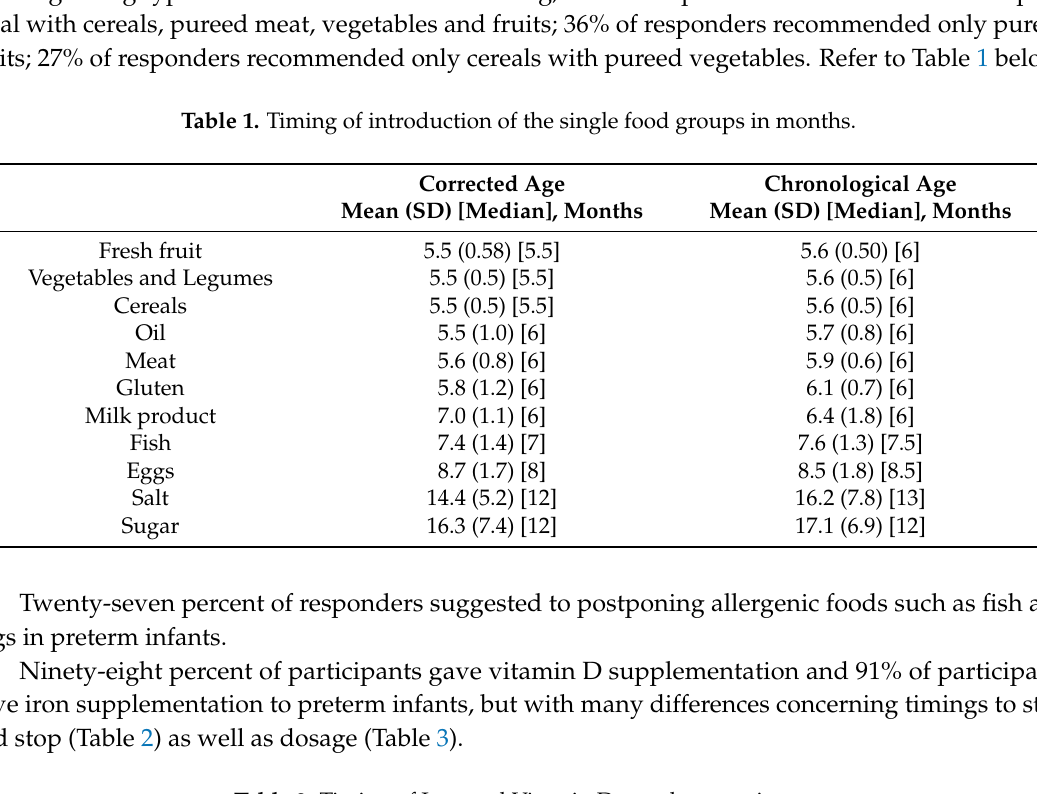
Table 2. Timing of Iron and Vitamin D